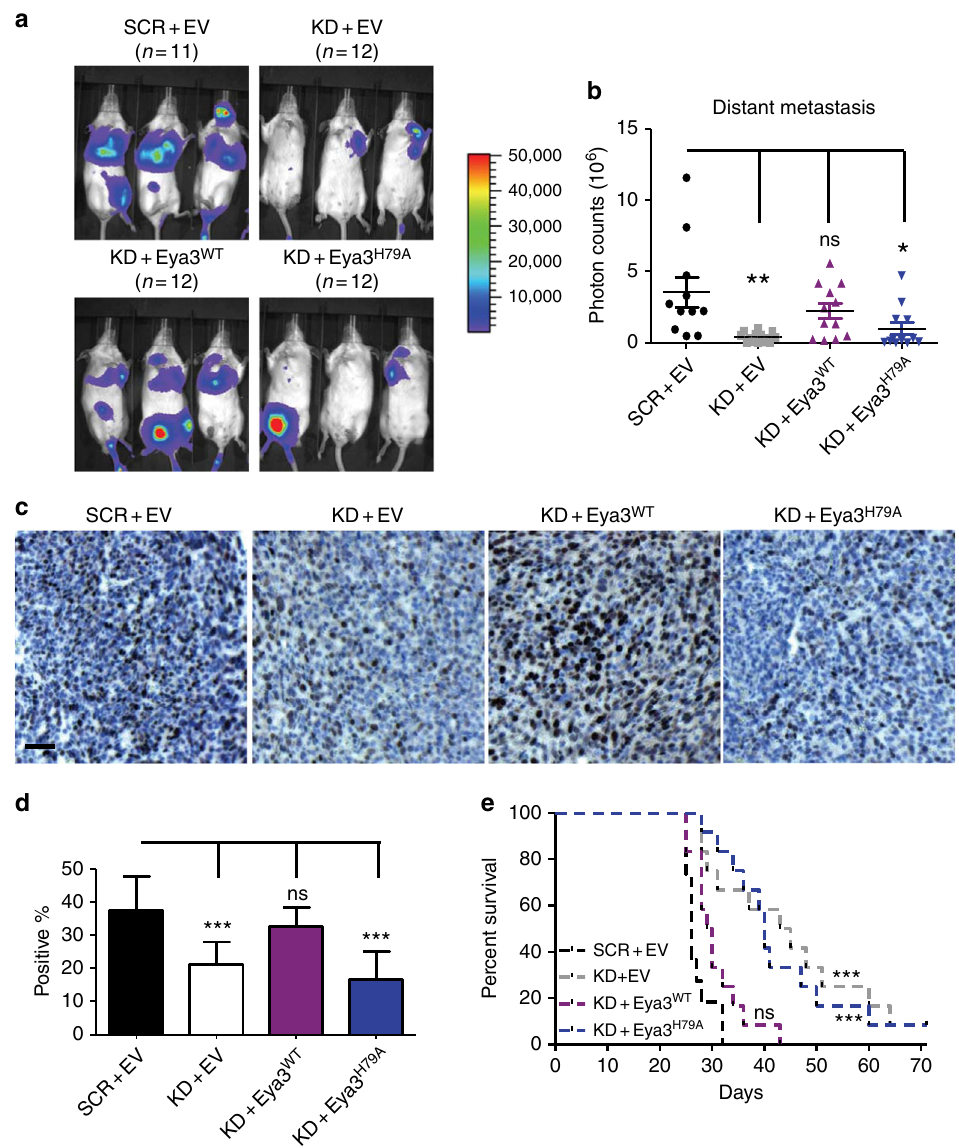
Fig. 6 Eya3 – PP2A-associated Thr phosphatase activity increases breast cancer metastasis and positively correlates with the percentage of c-Myc-positive regions in lung metastases. Experimental metastasis assay was performed by injecting BALB/c mice with fi re fl y luciferase-tagged 66cl4 cells as follows: SCR + EV, KD + EV, KD + Eya3 WT , or KD + Eya3 H79A . a Representative bioluminescent images of metastatic burden in mice at week 3 after injection. b Quanti fi cation of photon fl ux in a , p -value is calculated using one-way ANOVA followed by Tukey test, * p < 0.05, ** p < 0.01. c Representative immunohistochemical staining of lung metastases using a c-Myc antibody. Note that the percentage of c-Myc positive cells is highest in the presence of WT Eya3 (either endogenous or addback), and is diminished with Eya3 KD or addback of the Eya3 H79A mutant. d Graph shows the quanti fi cation of c-Myc positive regions across different conditions. Percentage of positive cells was assessed using ImageJ software. p -value was calculated using one-way ANOVA followed by Tukey test, *** p < 0.001, error bars: standard deviation. 20 metastases from each condition were examined, scale bar: 20 μ m. e Kaplan – Meier curves demonstrate the percentage of mice that survived until day 70. p -value is calculated using the log-rank test followed by Bonferroni correction, *** p <